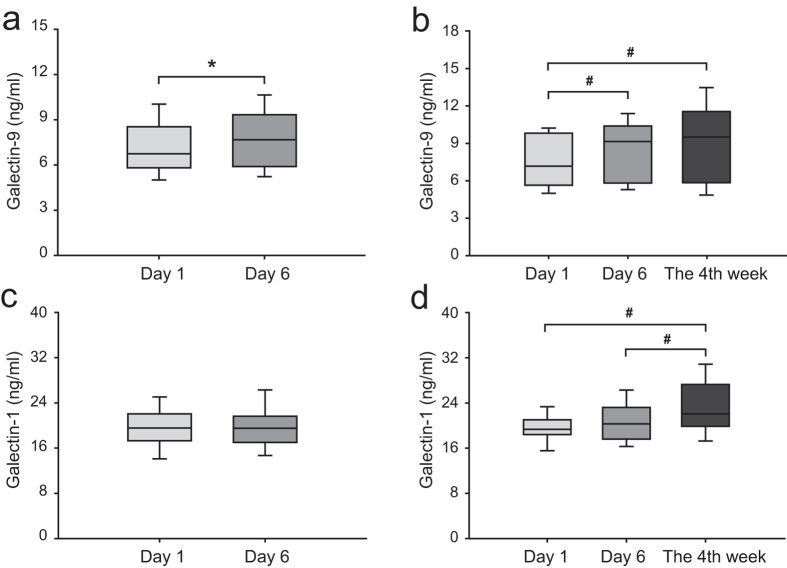
Serum levels of galectin-9 and galectin-1 in patients at different time points after ischaemic stroke.(a and c) comparisons of galectin-9 and galectin-1 levels between day 1 and day 6 after stroke in 109 patients. The differences were compared using the Wilcoxon signed-rank test (a) or a matched t-test (c). *p < 0.05. (b and d), comparison of galectin-9 and galectin-1 levels between day 1, day 6, and 4 weeks after stroke in 39 patients. The differences between the three time points were compared using the Friedman M test with post hoc Wilcoxon signed-rank tests (b) and repeated measures ANOVA with post hoc matched t-tests (d). #p < 0.0125 was considered statistically significant after the Bonferroni correction.